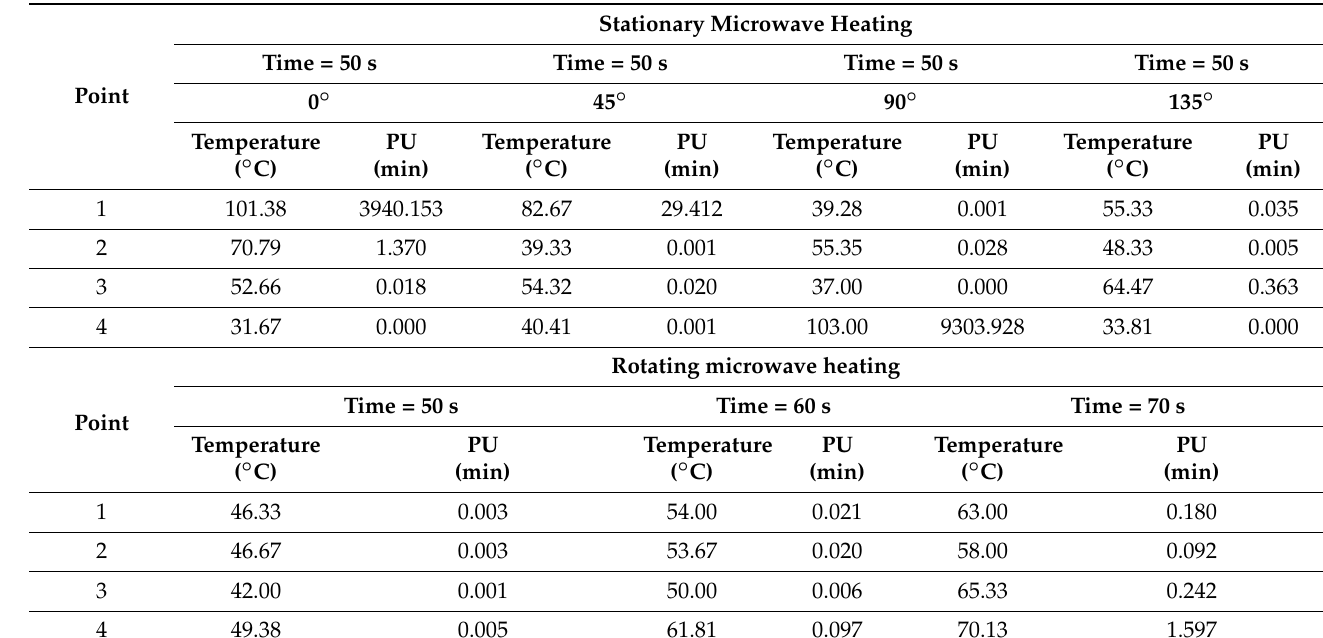
Table 3. Comparison of PU between stationary and rotating microwave